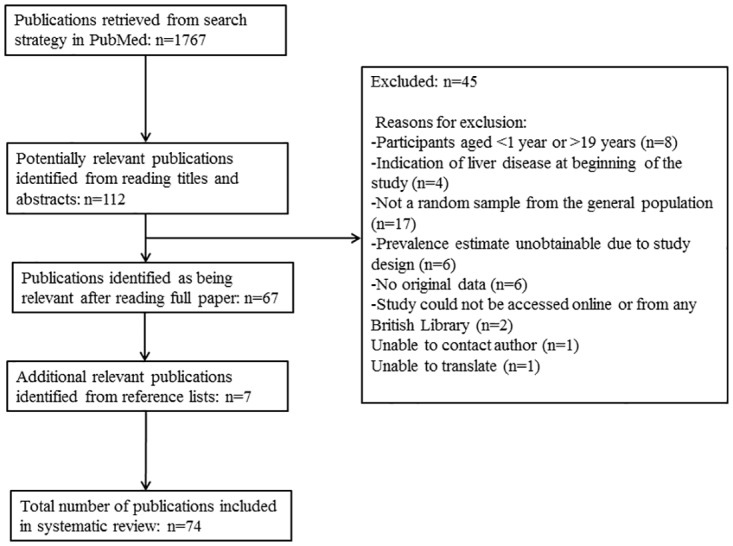
Study Selection.